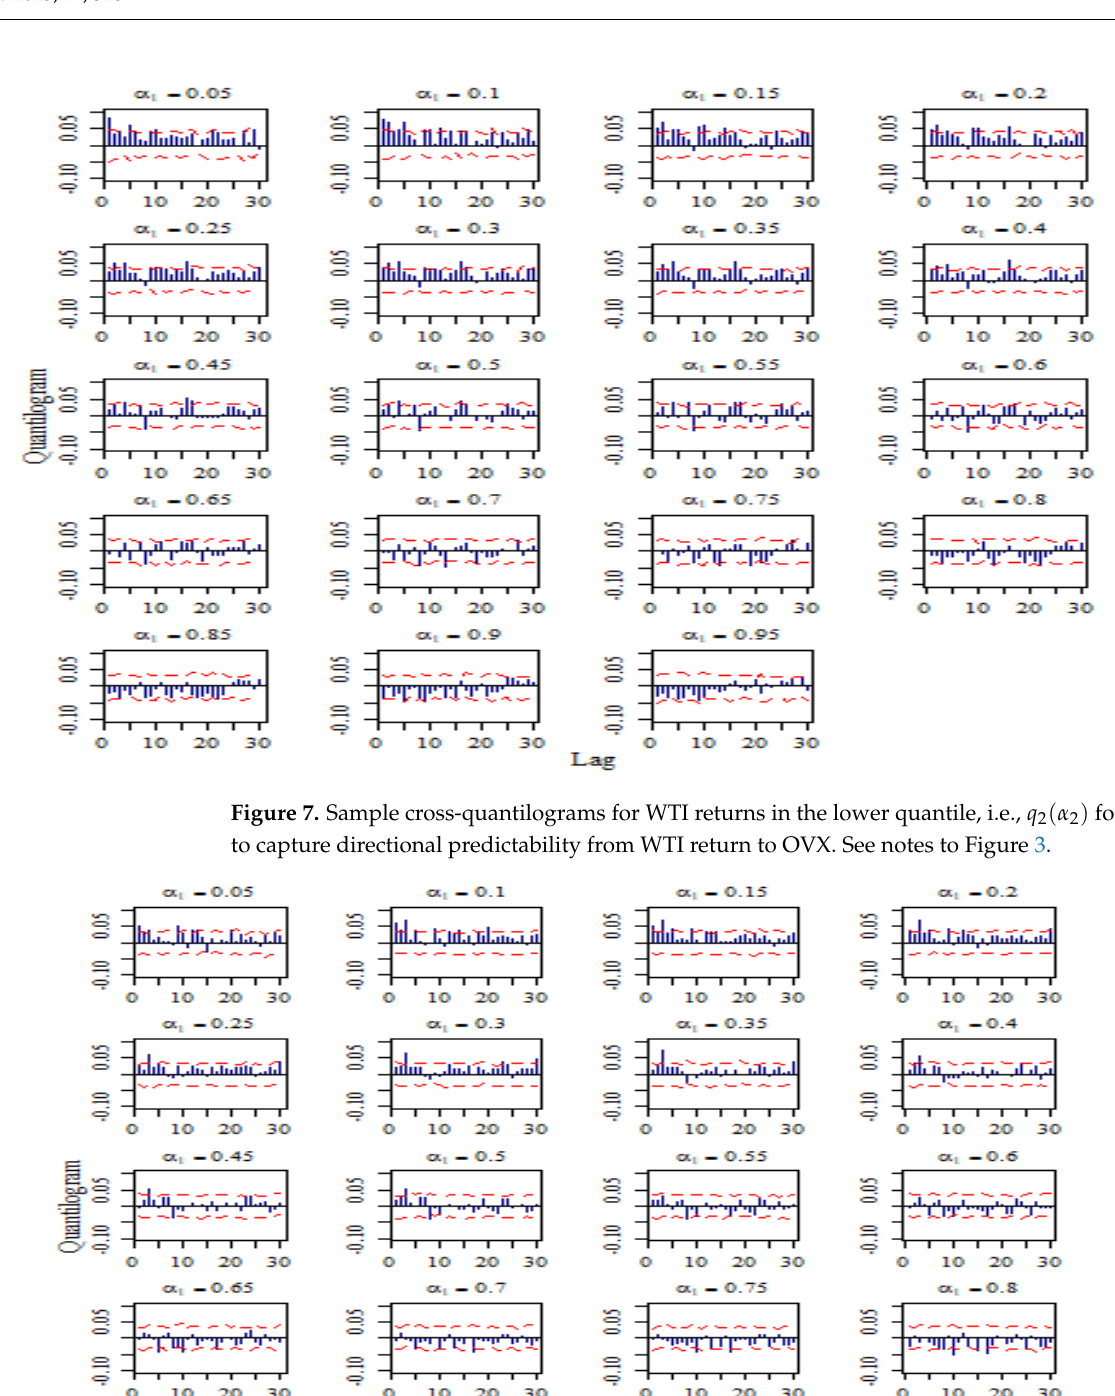
Figure 8. Sample cross-quantilograms for WTI returns in the median quantile, i.e., q 2 ( α 2 ) for α 2 = 0.5, Figure 8 . Sample cross-quantilograms for WTI returns in the median quantile, i.e., to capture directional predictability from WTI to OVX returns. See notes to Figure 0.5